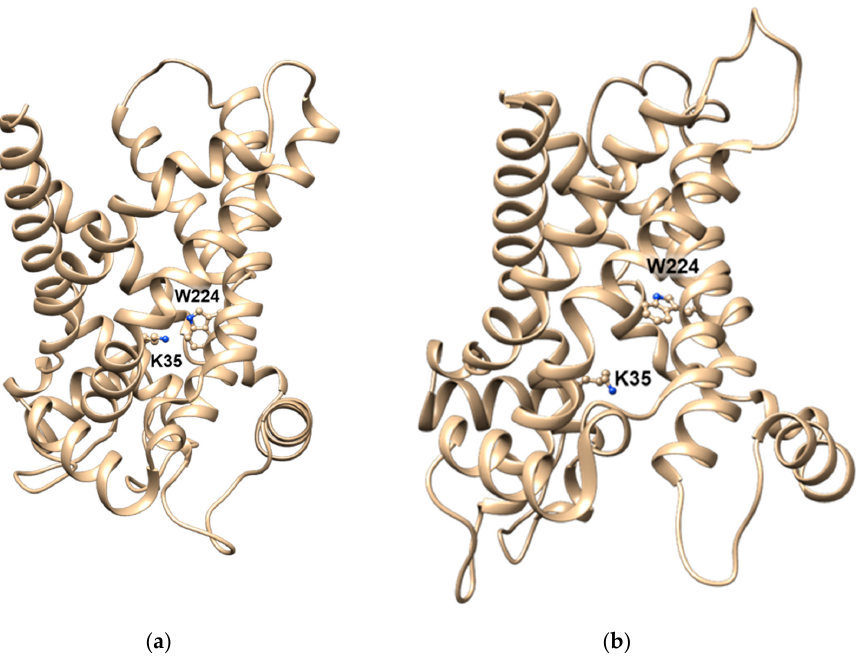
Figure 7. Lateral views of the CAC structural model showing the residues involved in the coupling of substrate-binding with gate opening and gate closing. ( a ) Ribbon diagram of the carrier in c-state in which the residues Trp 224 and K35 are at a distance of 4 Å and are depicted with a ball and stick; ( b ) ribbon diagram of the carrier in m-state in which the residues Trp 224 and K35 are at a distance of 12 Å and are depicted in ball and stick.